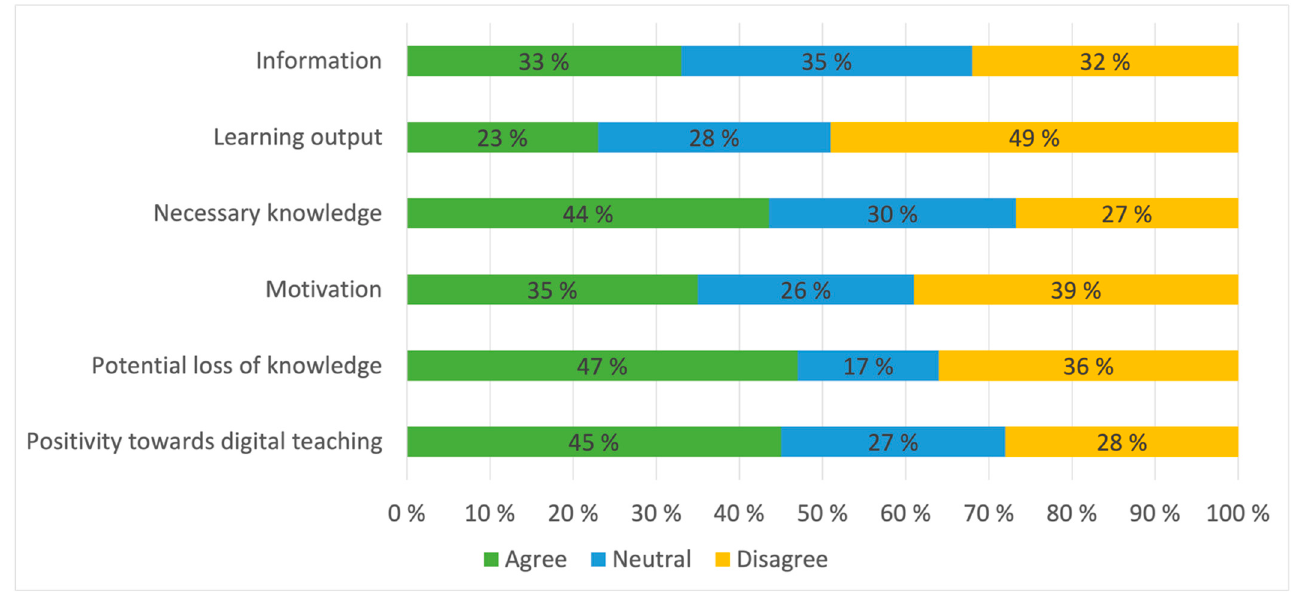
Figure 4. Student attitude to questions regarding their own learning experience this semester. Infor-